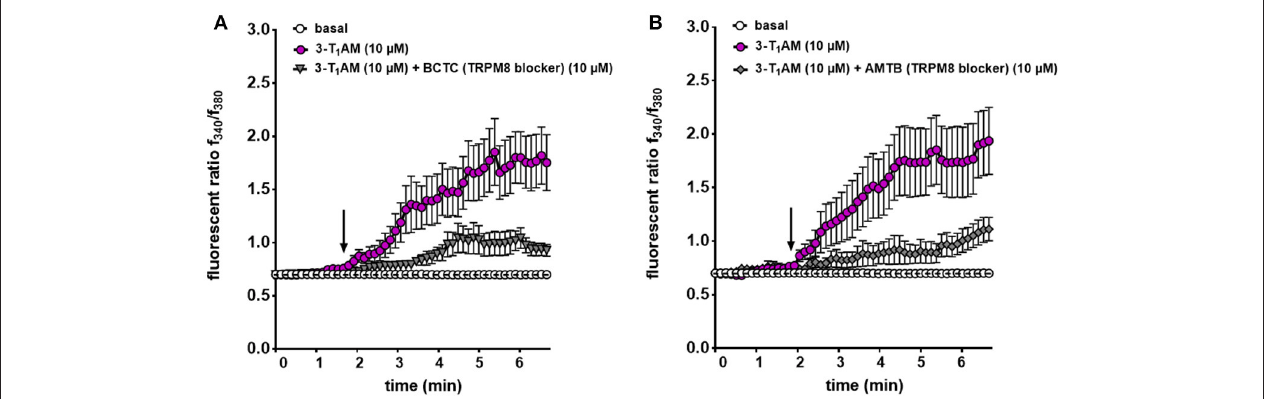
FIGURE 6 | TRPM8 mediates 3-T 1 AM-induced Ca 2 + response in N41 cell line. Cells were pre-incubated with inhibitors (10 µ M AMTB or 10 µ M BCTC) 30min before the measurement. Stimulation was performed with 10 µ M 3-T 1 AM and Ca 2 + influxes were measured ( n = 15–19) with and without the inhibitors. (A) 3-T 1 AM increased Ca 2 + influx and pre-incubation with BCTC significantly suppressed this effect. (B) AMTB showed the similar inhibitory effect on 3-T 1 AM-induced Ca 2 + influx. Experiments were performed in 400s. Compounds were added to cells at the time points indicated by the arrow and n indicates number of the single cells. The total number of cells was collected in 5 independent experiments. Values represent mean ± SEM.